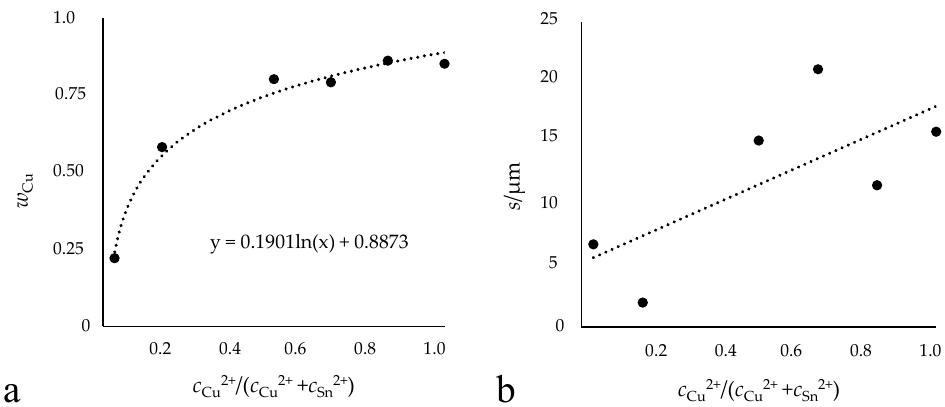
Figure 1. Illustration of the relationship between electrolyte composition and resulting alloy layer. Amount of copper in the layer ( a ) and the obtained layer thickness ( b ). Deposition of Cu − Sn in [EMIM]Cl with different Cu and Sn concentration ratios (0.5 A/dm 2 , 95 °C, 100 rpm, 10,800 s) outside the glove box.